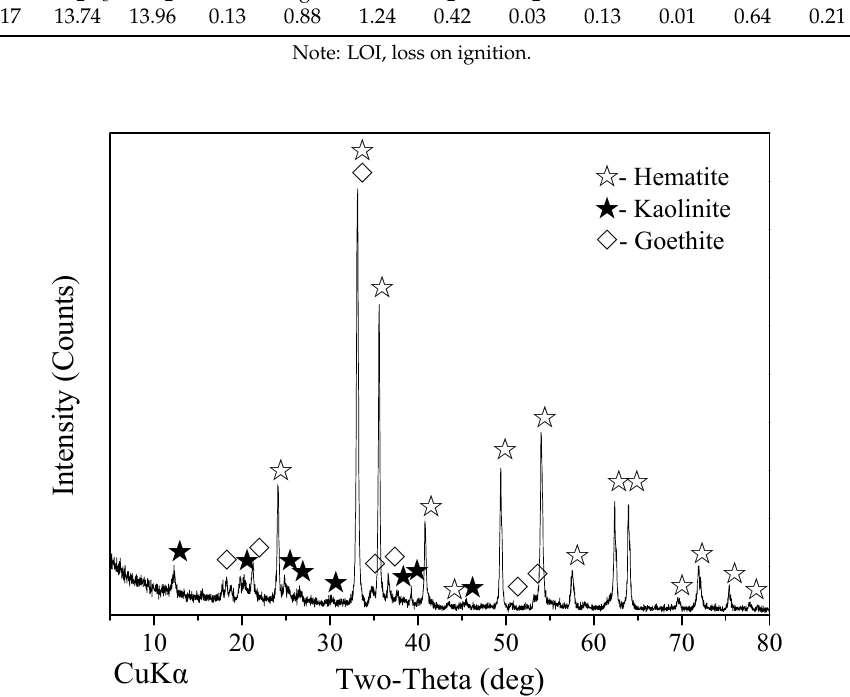
Table 1. Chemical compositions of high-aluminum hematite-limonite ore (wt. %). Chemical Compositions (wt. %) Fe total